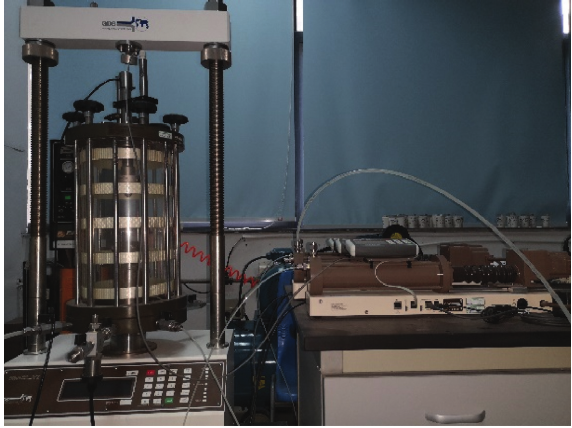
Figure 6: GDS triaxial test